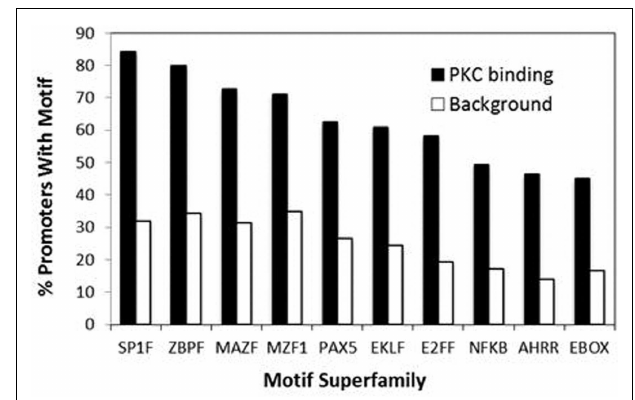
FIGURE 3 | Motif superfamilies identified within promoters of PKC- θ bound genes. A greater proportion of the promoters of the PKC-bound genes had motifs for members of the SP1F, ZBPF, MAZF, MZF1, PAX5, EKLF, E2FF, NFKB, AHRR, and EBOX motif superfamilies, when compared to a background set of promoters.The representative members of the superfamilies shown are SP1_01 (SP1F), ZNF219_01 (ZBPF), MAZR_01 (MAZR), MZF1_01 (MZF1), PAX5_01 (PAX5), EKLF_01 (EKLF), NFKAPPAB_01 (NFKB), E2F_03 (E2FF), AHRARNT_02 (AHRR), and MYCMAX_03